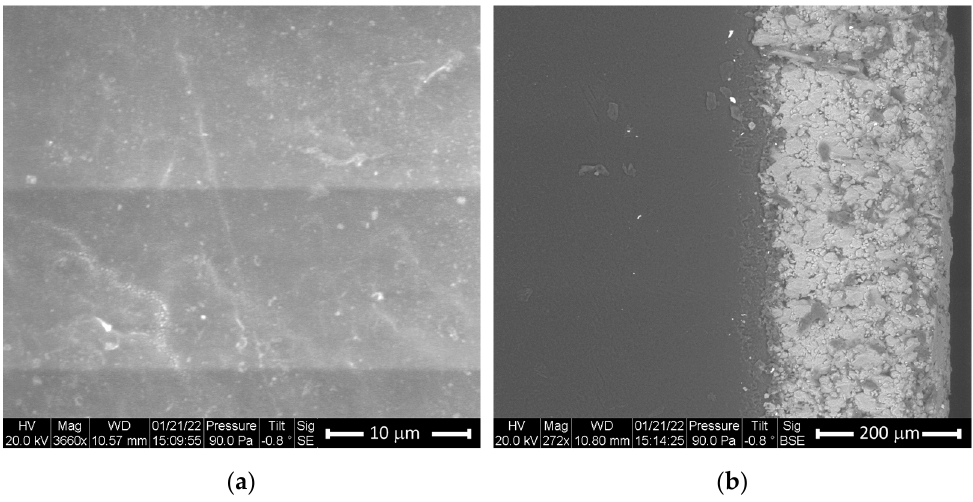
Figure 1. ESEM images: ( a ) uncoated PEEK surface; ( b ) PEEK with aluminum coating.